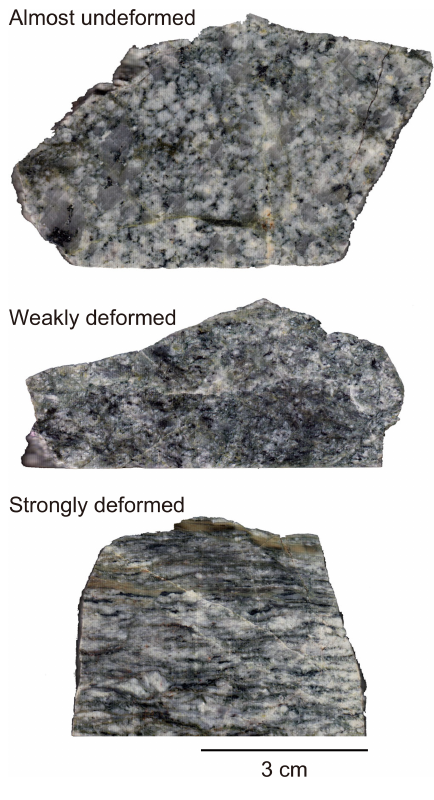
Figure 2. Scanned images of the three studied samples of the Wariyama granite. The two deformed samples were cut parallel to the lineation and perpendicular to the